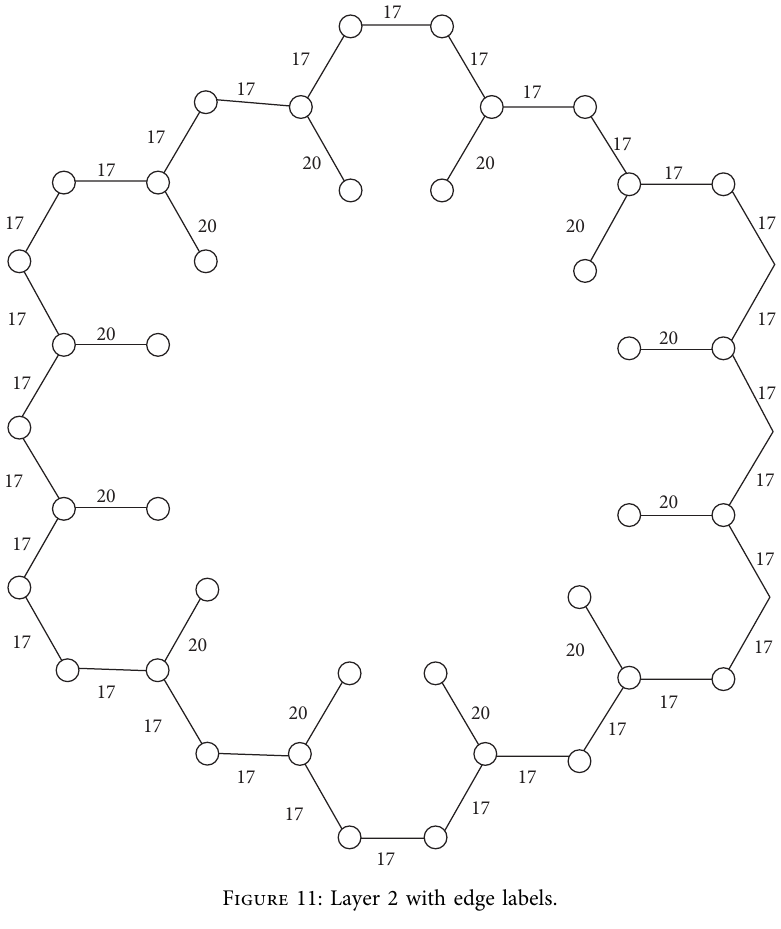
Figure 11: Layer 2 with edge labels.